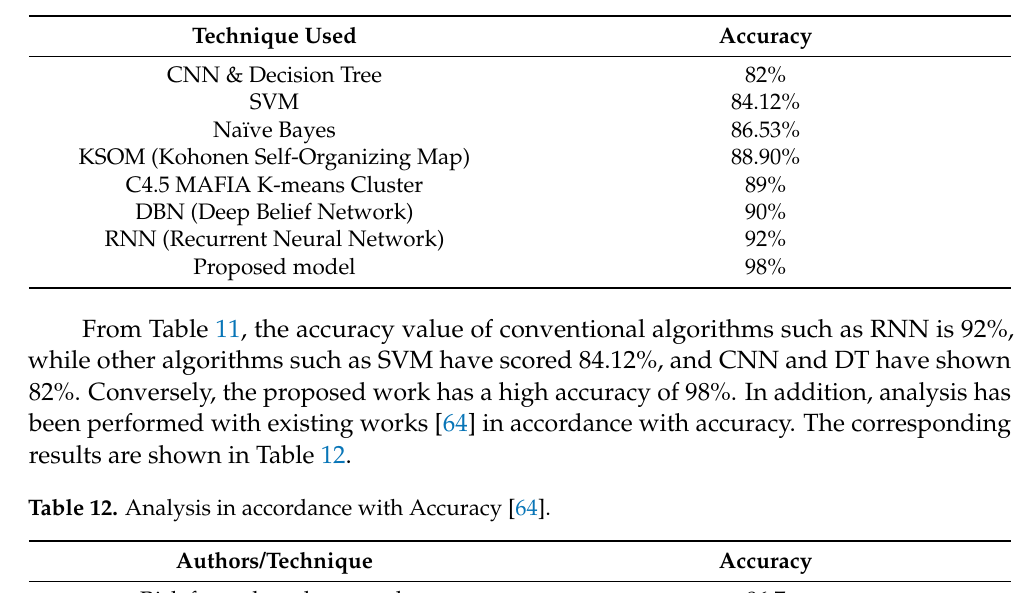
Table 11. Analysis with regard to Accuracy [63].